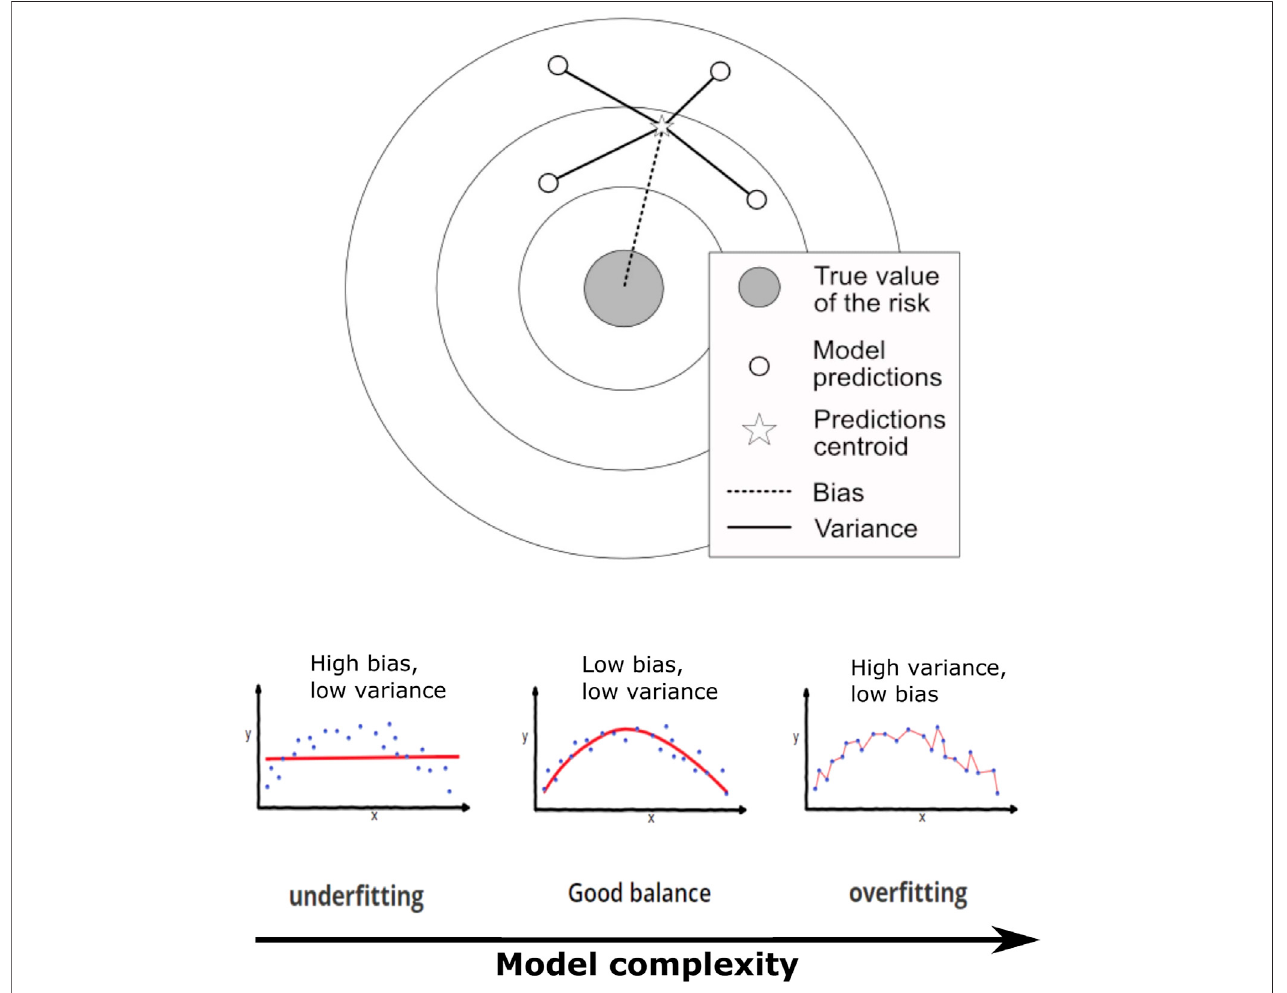
FIGURE 1 | Representation of the bias-variance tradeoff from a risk